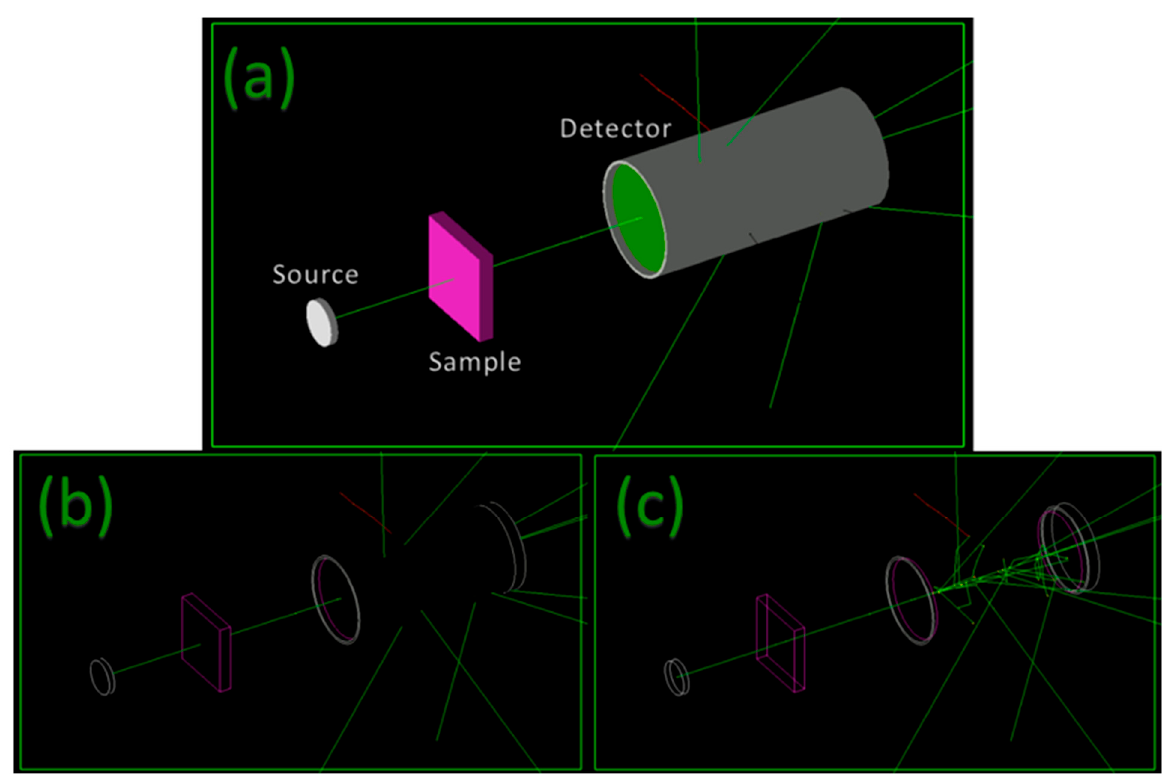
Figure 2. Geant4 visualization of the developed code. ( a ) Solid surface view, ( b ) wire frame view, ( c ) hidden edges view.